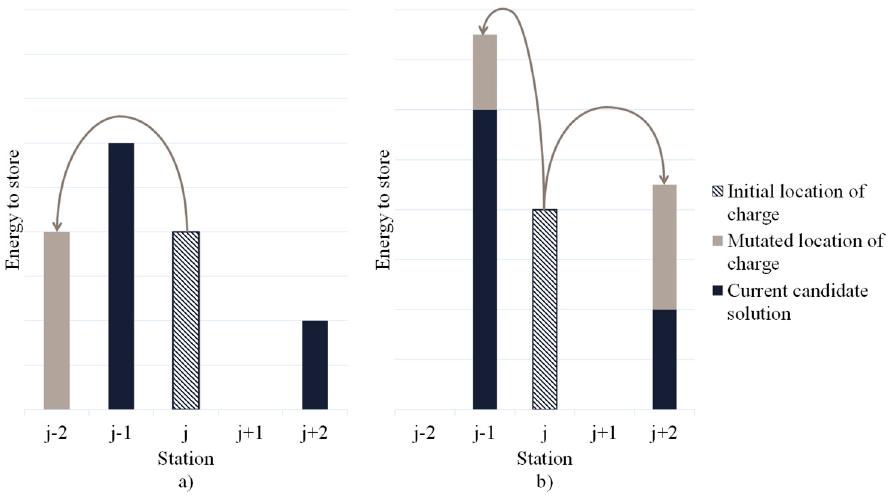
Figure 4. Proposed mutations ( a ) Move , ( b ) Distribute from an initial solution with scheduled stops at charging station j − 1, j, and j + 2.